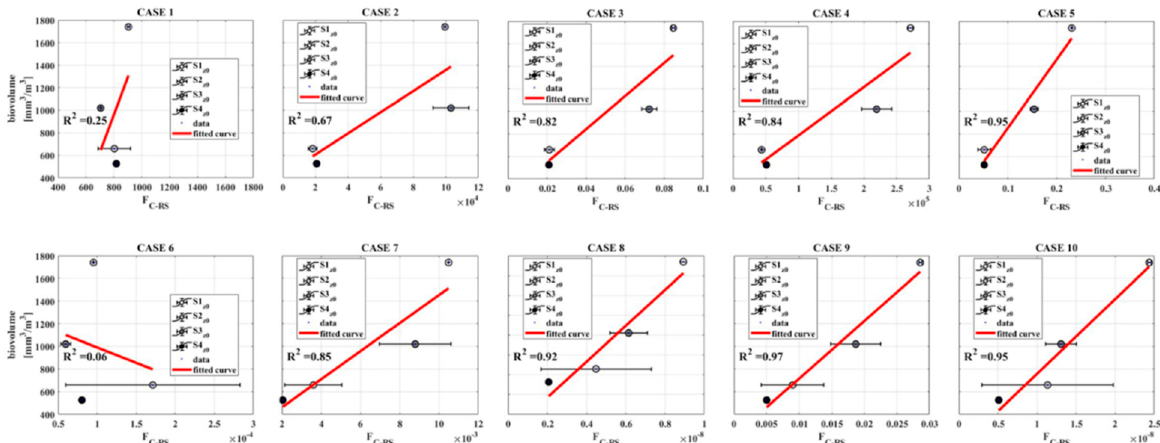
Figure 9. The first row shows the cases in which the Φ C proxy has been kept constant, while the F A has been replaced by hyperspectral measurements and indices. Second row shows the cases in which also the Φ C has been replaced by a proxy defined from remote sensed quantities. The red lines correspond to the linear regression performed on the measurements. The scale for F C-RS have been omitted on purpose because due to the approximations taken only a qualitative comparison was possible.